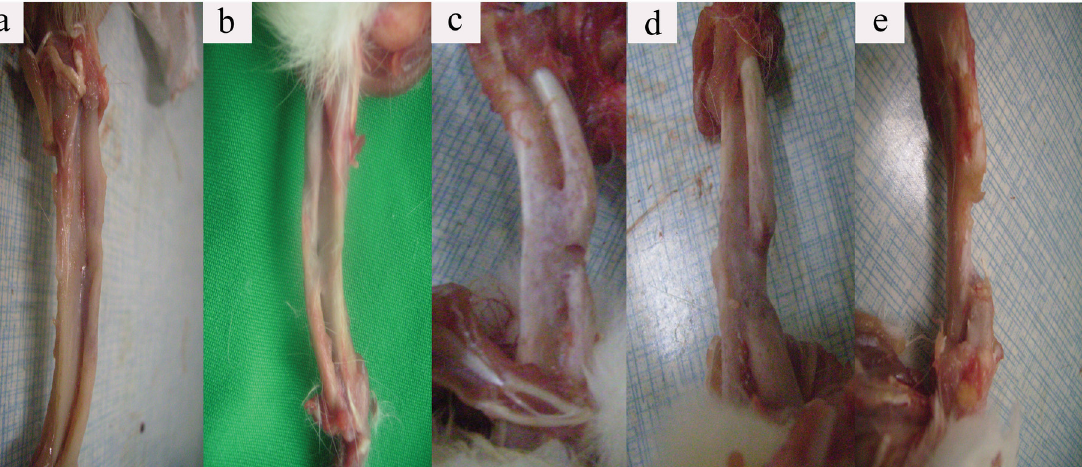
Fig 2. Gross observation of different radius defects after euthanasia at 12 weeks. Both the borders and center of the defects were covered by a newly formed and irregularly-shaped callus, which declined gradually with the defect size increasing (a: 1.0cm, b: 1.2cm, c: 1.4cm, d: 1.7cm, e: 2.0 cm).